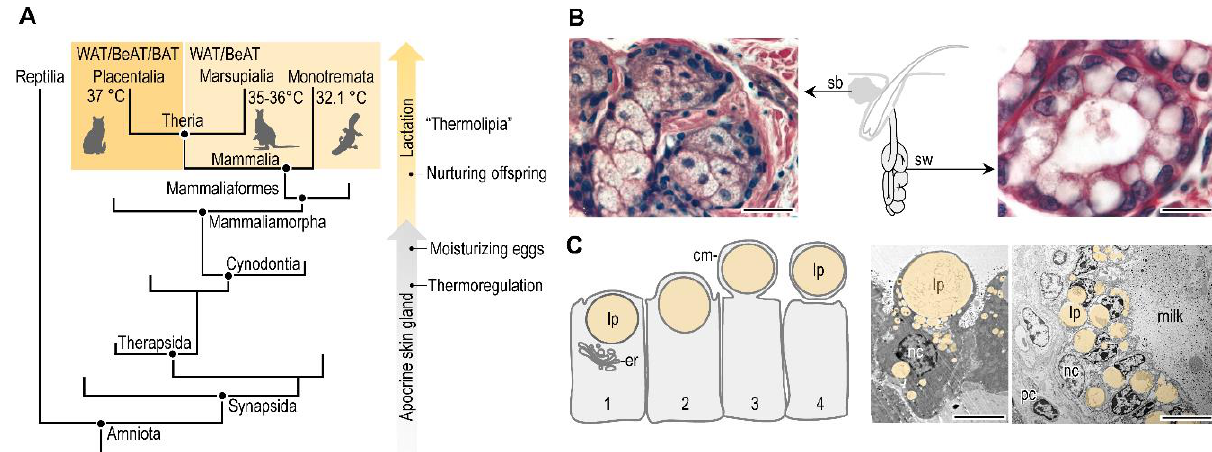
Figure 5. Evolution of breastfeeding. ( A ) Simplified phylogenic tree of mammals and their evolutionary forerunners. Relative time scale of the acquisition of homeothermy and the advent of lactation are shown. Placentalia have a core body temperature of 37 °C, and develop white adipose tissue (WAT) and thermogenic adipose tissue: brown adipose tissue (BAT) and beige- or induced brown adipose tissue (BeAT). Marsupialia have a lower core body temperature (35 – 36 °C) than the mammals, such as the Monotremata (around 32 °C). Marsupialia and Monontremata develop WAT, while BeAT only upon induction [160,161]. Developing BeAT depots is a form of adaptive thermogenesis. ( B ) Histology of the mammalian skin glands: sebaceous gland (sb) and sweat gland (sw) [162]. The sebaceous gland cells are filled with lipid droplets and undergo apoptosis as a mechanism of holocrine lipid secretion. The sweat glands have an apocrine secretion mechanism, and the image shows large secretory droplets in the apical regions of the gland cells. Hematoxylin and eosin staining, scale 25 μm. Both glands are associated with the hair follicle. ( C ) Lipid secretion mechanism of the lacteal gland (or breast gland) [12]. Note the apocrine release of the lipid droplet (lp), enveloped in the cell membrane (cm). er: endoplasmic reticulum. Transmission electron microscopy images of gland cells in the breast of lactating mouse and cattle. nc: nucleus, lp: lipid droplet, pc: plasma cell. Scale bar 2 μm.